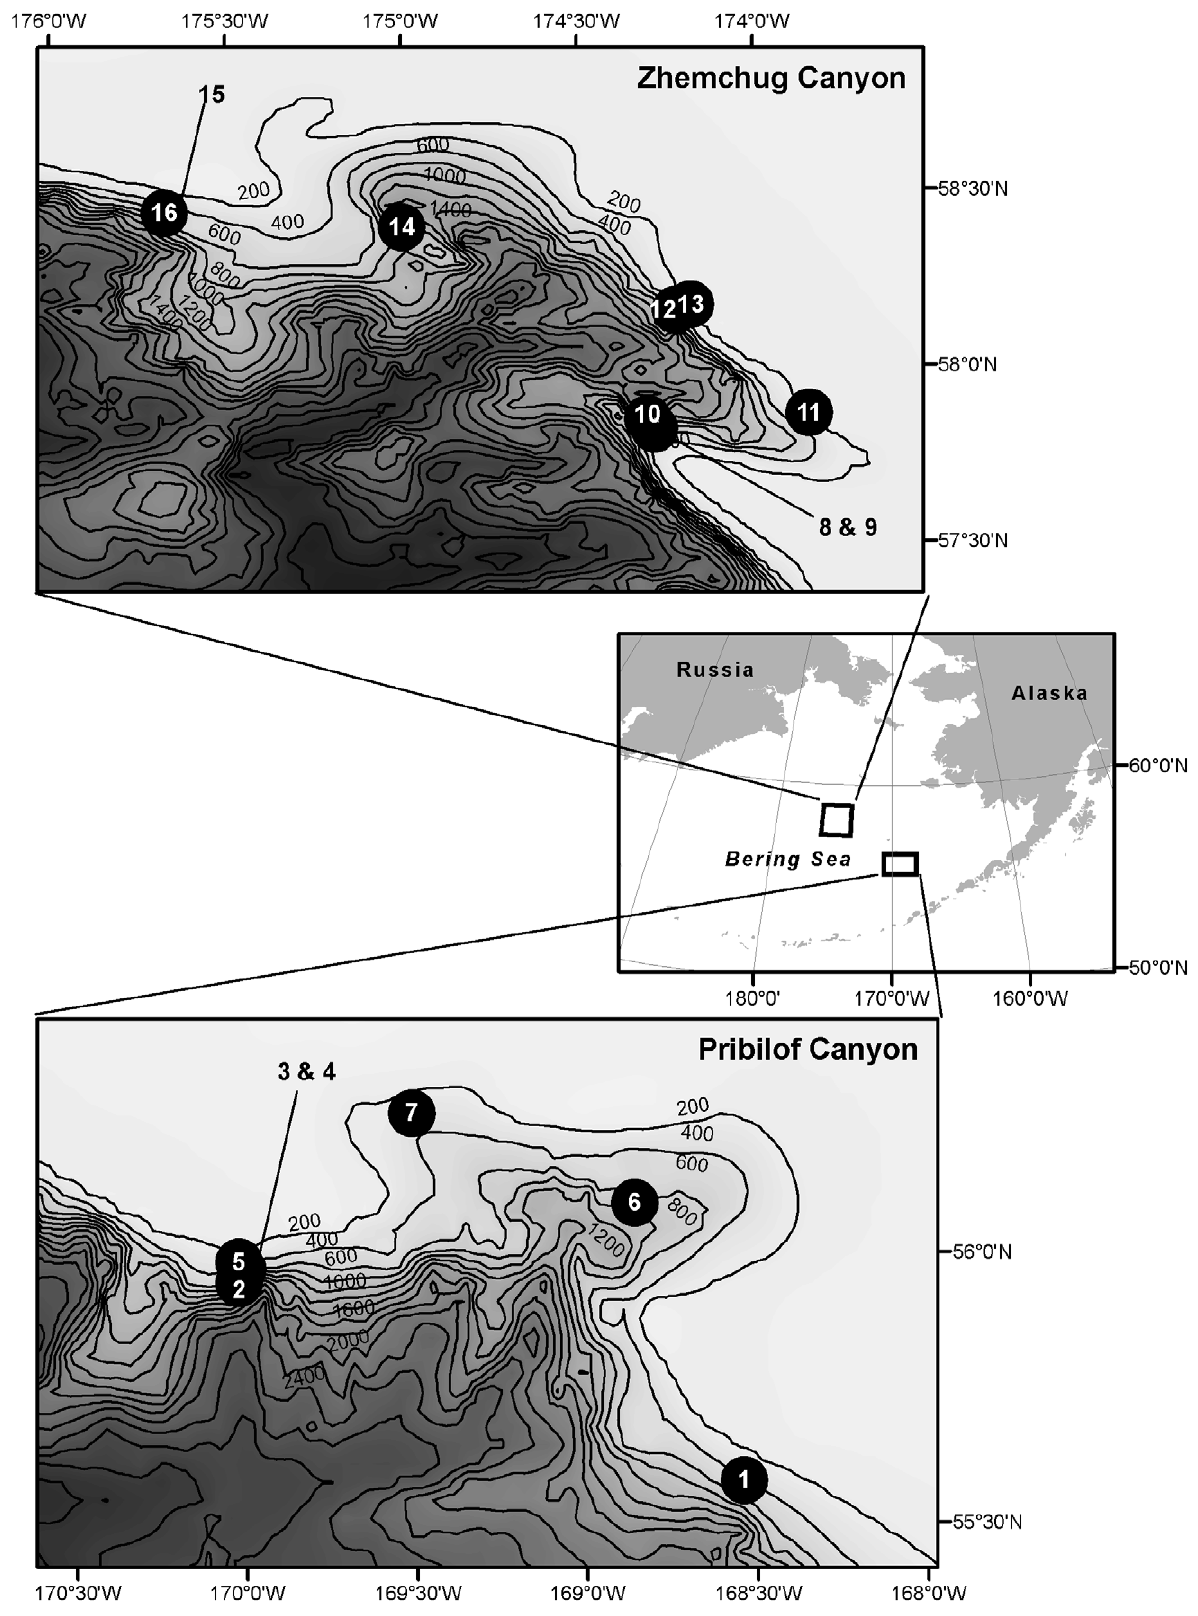
Figure 1. Map of study area showing locations of canyons and submersible transects.